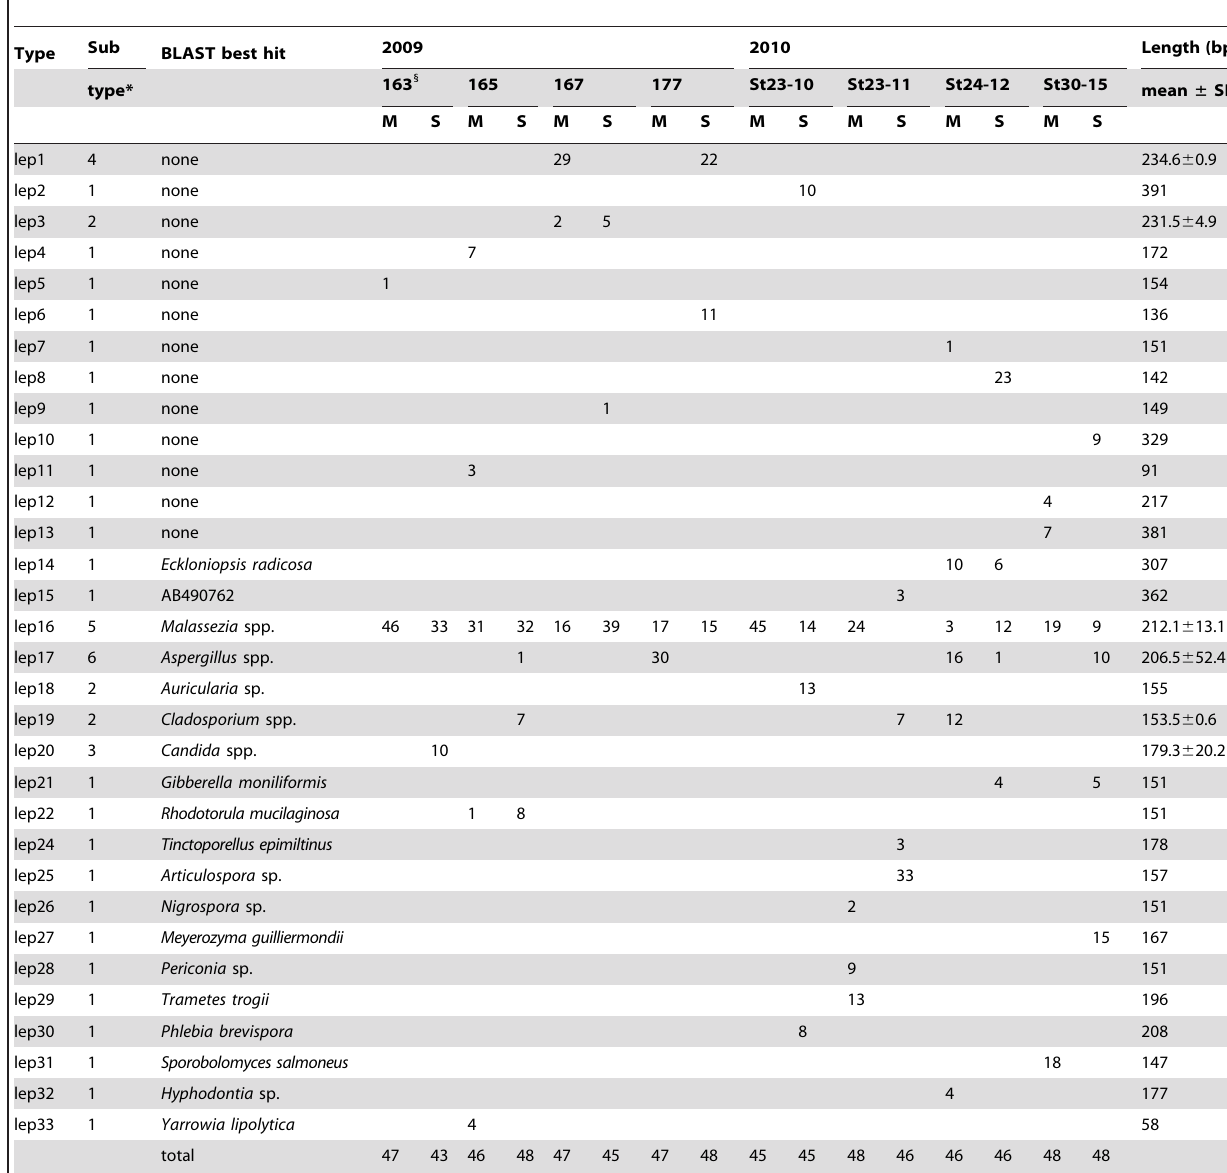
Table 3. Assignments of ITS1 fragments detected from dorsal muscle (M) and intestine (S) of eight eel